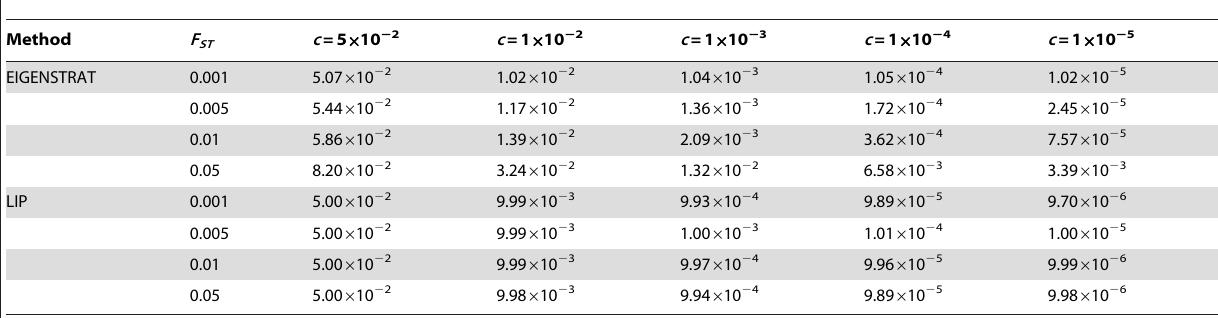
Table 3. Average of empirical proportion at 100K GWAS.